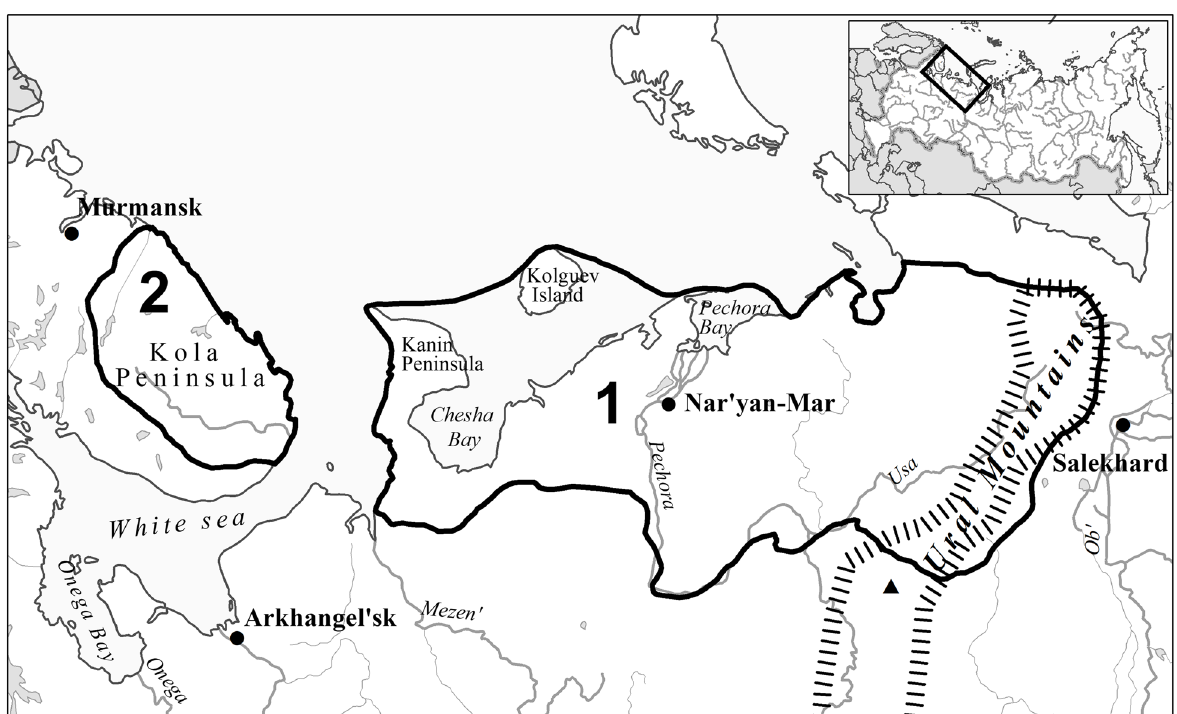
Fig. 1 Reindeer herding areas of the European part of Russia: (1) Archangelsk tundras and (2) the modern Kola Peninsula reindeer herding